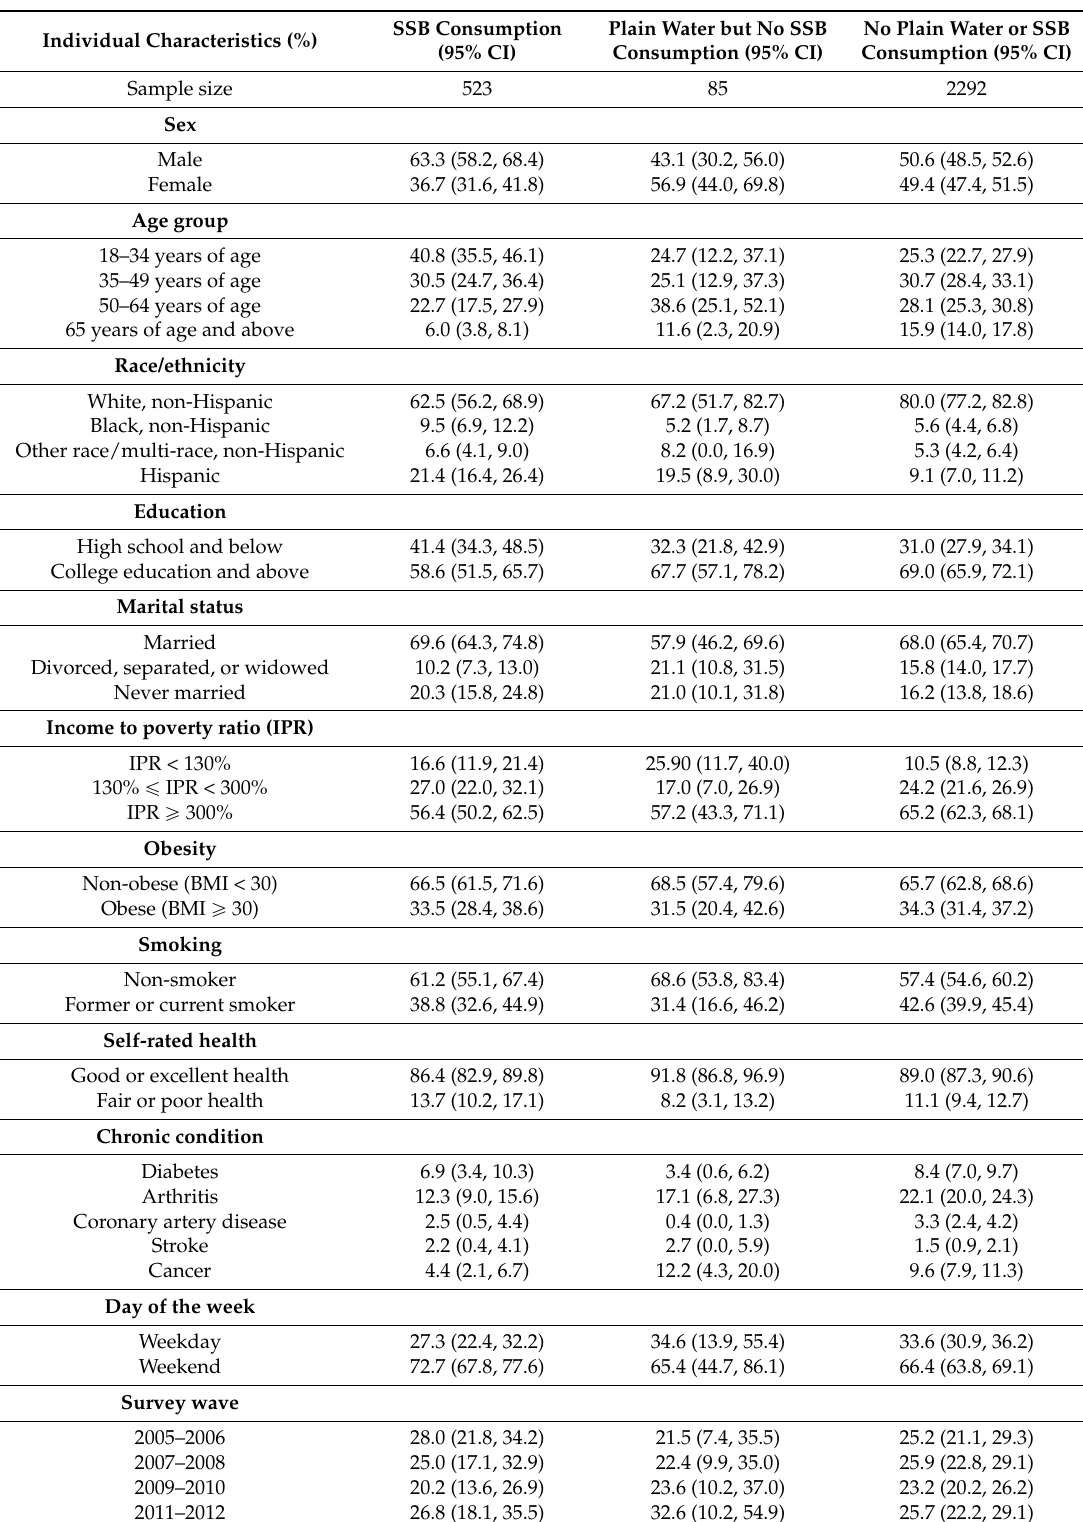
Table 1. Individual characteristics of 2005–2012 NHANES adult full-service restaurant consumers by plain water and sugar-sweetened beverage (SSB) consumption